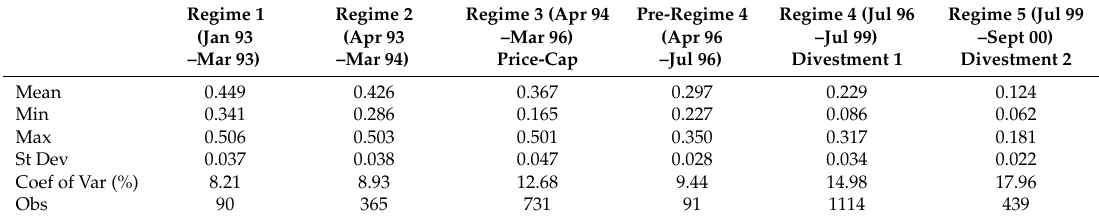
Table 2. Summary statistics for NP’s market share during the peak-demand period over trading days.